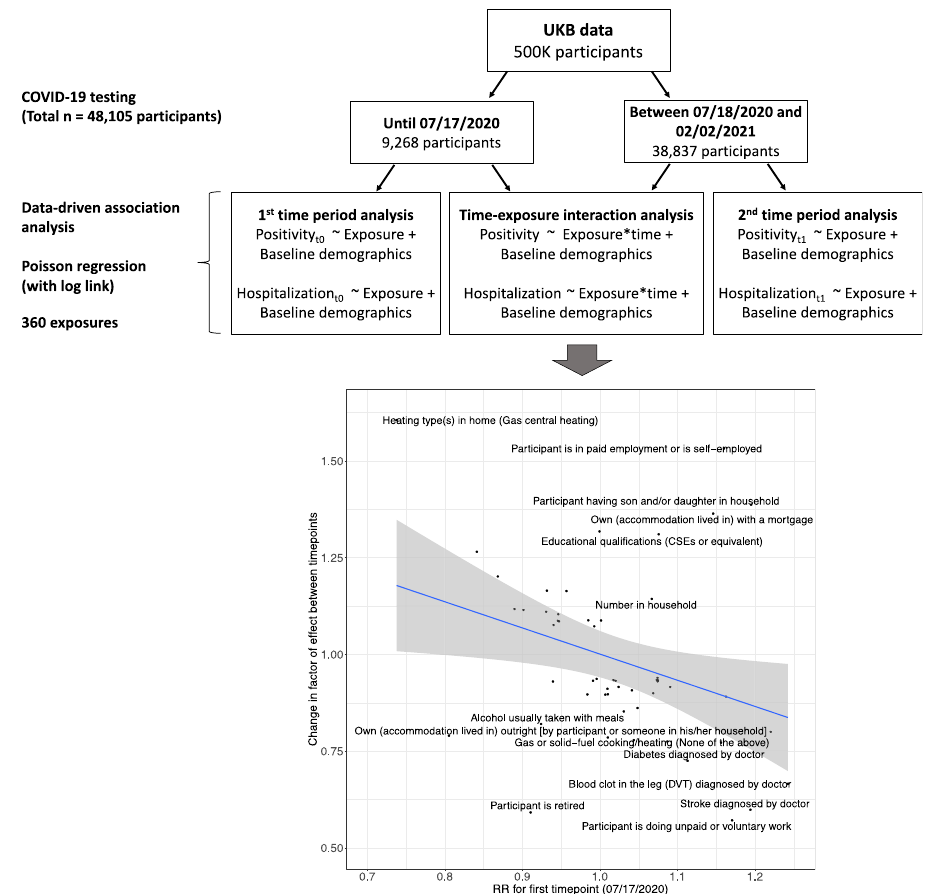
Fig. 1 Schematic overview of data-driven analysis of COVID-19 positivity risk factors across two timepoints. This schematic diagram depicts the analytic pipeline. (1) COVID-19 testing data was collected from two time periods (until 07/17/2020 and between 07/18/2020 and 02/02/2021). (2) Data-driven association analysis was performed for each of the 360 exposures using Poisson regression (with log link). Associations were computed for each time period separately. Additionally, models were run to assess time-exposure interaction effects. The blue line on the scatterplot represents a linear regression line and the grey shading around it represents the 95% con fi dence